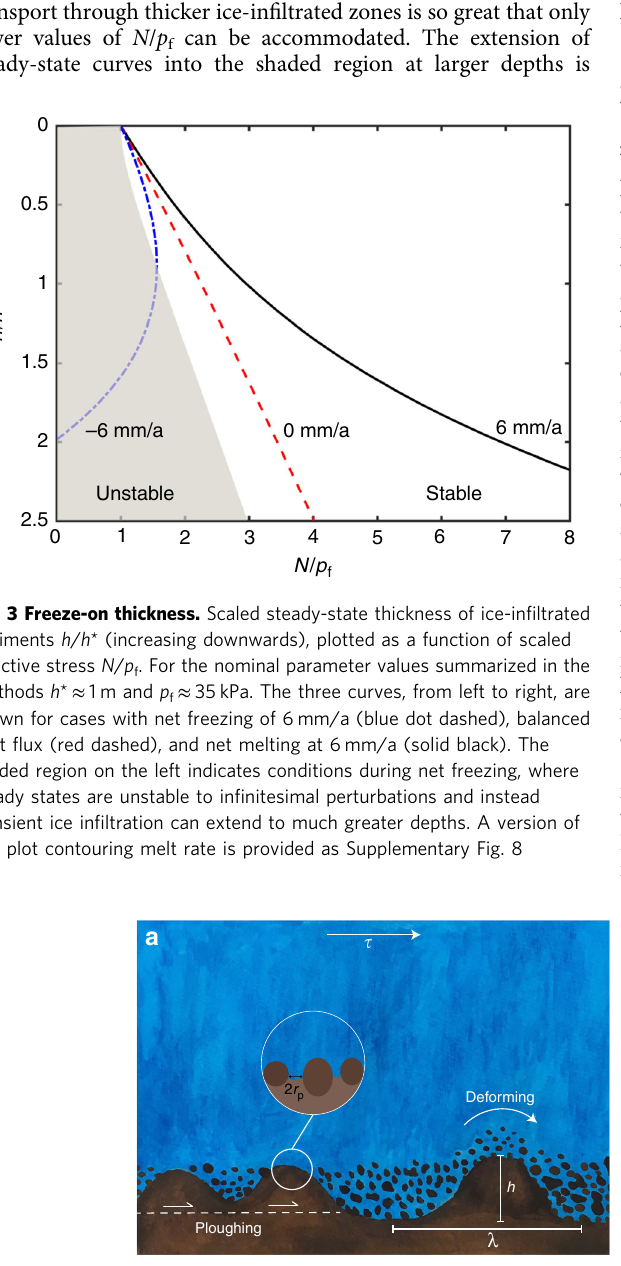
Fig. 4 Sliding over beds roughened by heterogeneous freeze-on. a Schematic illustration of deformation mechanisms that accommodate motion over basal sediments with heterogeneous ice in fi ltration of amplitude h and wavelength λ . b The scaled shear stress τ / p f as a function of wavelength λ for obstacles with the amplitudes h listed in the legend (with _ m ¼ 0 and values of N / p f from Fig. 3 of 1.1, 2.2, and 3.4, respectively). Cases with different sliding velocities are shown as solid lines for u = 1 m/a, dashed lines for u = 10 m/a, dot-dashed for u = 100 m/a, and dotted for u = 1 km/a. Ploughing of liquid- saturated sediments is favored for shorter wavelengths and lower amplitudes, whereas deformation is expected over stronger